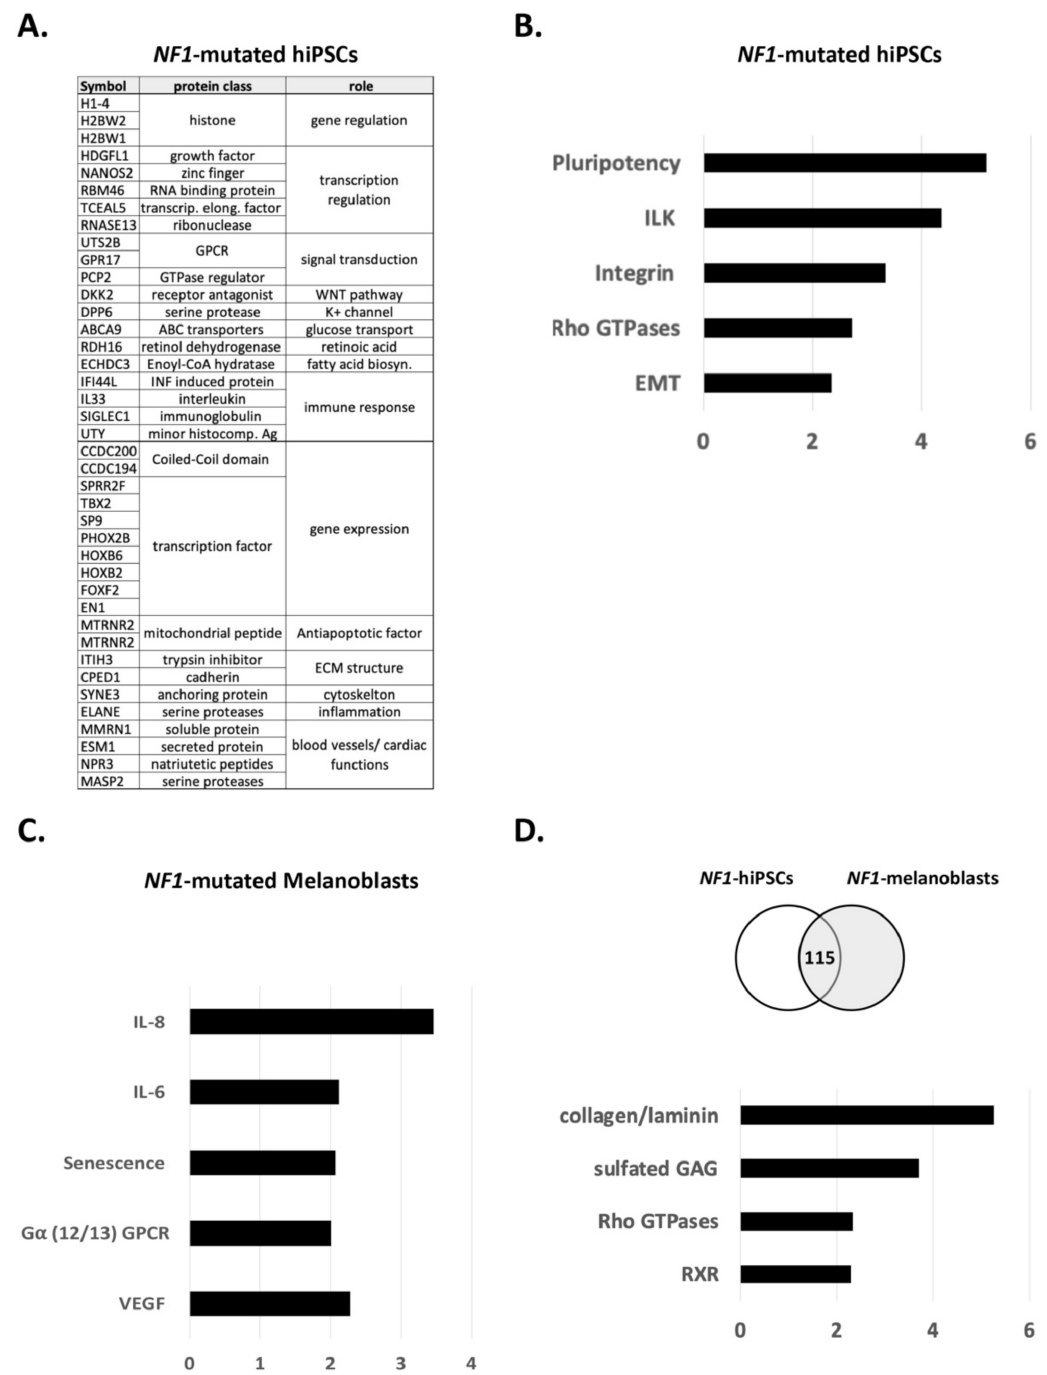
Figure 1. NF1 mutations have a differential impact on pluripotency and on differentiation. ( A ) Top 20 regulated genes in NF1 -mutated hiPSCs compared to NF1 -WT hiPSCs. ( B ) Main regulated signaling pathways in NF1 -mutated hiPSCs compared to NF1 -WT hiPSCs. ( C ) Main regulated signaling pathways in NF1 -mutated melanoblasts compared to NF1 -WT melanoblasts. ( D ) Common regulated signaling pathways in NF1 -mutated hiPSCs and in NF1 -mutated